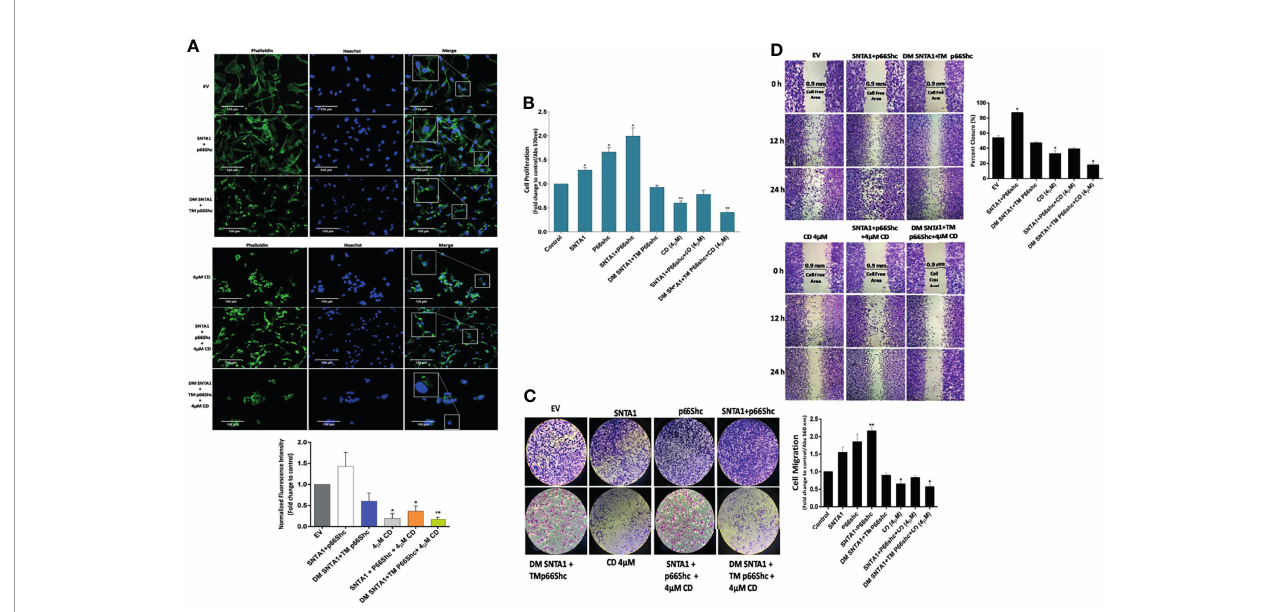
FIGURE 5 | Loss of SNTA1-p66Shc interaction and RhoA activation alters actin organization,cellproliferation and migration in MDA-MB-231 breast cancer cells. (A) Representative fl uorescent photomicrographs illustrating changes in F-actin organization inMDA-MB-231 cells expressing the mentioned plasmid constructs and/or treatedwith cytochalasin D.The bar graphs show the foldchange in fl uorescent intensity of phalloidin stained F-actinin comparison to EV control. (B) The bar graph shows the proliferativepotential of MDA-MB-231 cells expressingthe mentioned plasmidconstructs and/or treatedwith cytochalasin D comparisonto control.Results shownwere repeatedthree times andare expressed as mean ± SD fold change over control levelset to 1 unit. The statistical analysis was done usingone-way ANOVA followed by Dunnett`s multiplecomparison test to determine level ofsigni fi cance. *P < 0.05; **P <0.01. (C) Representative photographs illustratingthe difference in migratorypotential in cells transfected with mentionedconstructs andtreated with cytochalasin D in comparison to control. The bar graphdepicts fold change inmigration incells transfectedwith mentioned constructs and treated with cytochalasin D incomparisonto control. (D) Representative photographs depicting wound healingpotential of the cellstransfected with mentionedconstructs andtreated with cytochalasin D in comparison to control. The bar graphshows fold-change in migratorypotential in cells transfected with mentioned constructs and treated with cytochalasin D incomparisonto control.Results are expressed as mean ± SD from three experiments. The statistical analysiswas done using one-way ANOVA followed byDunnett`s multiplecomparison testto determine level of signi fi cance. *P <